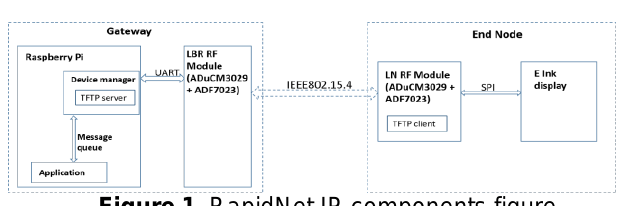
Figure 1. RapidNet IP components figure